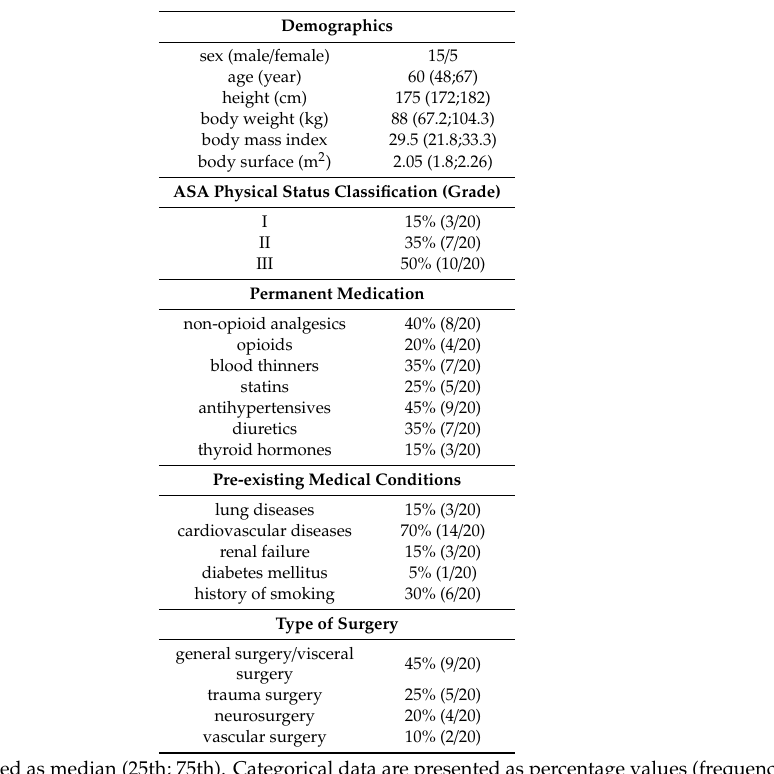
Table 1. Patients’